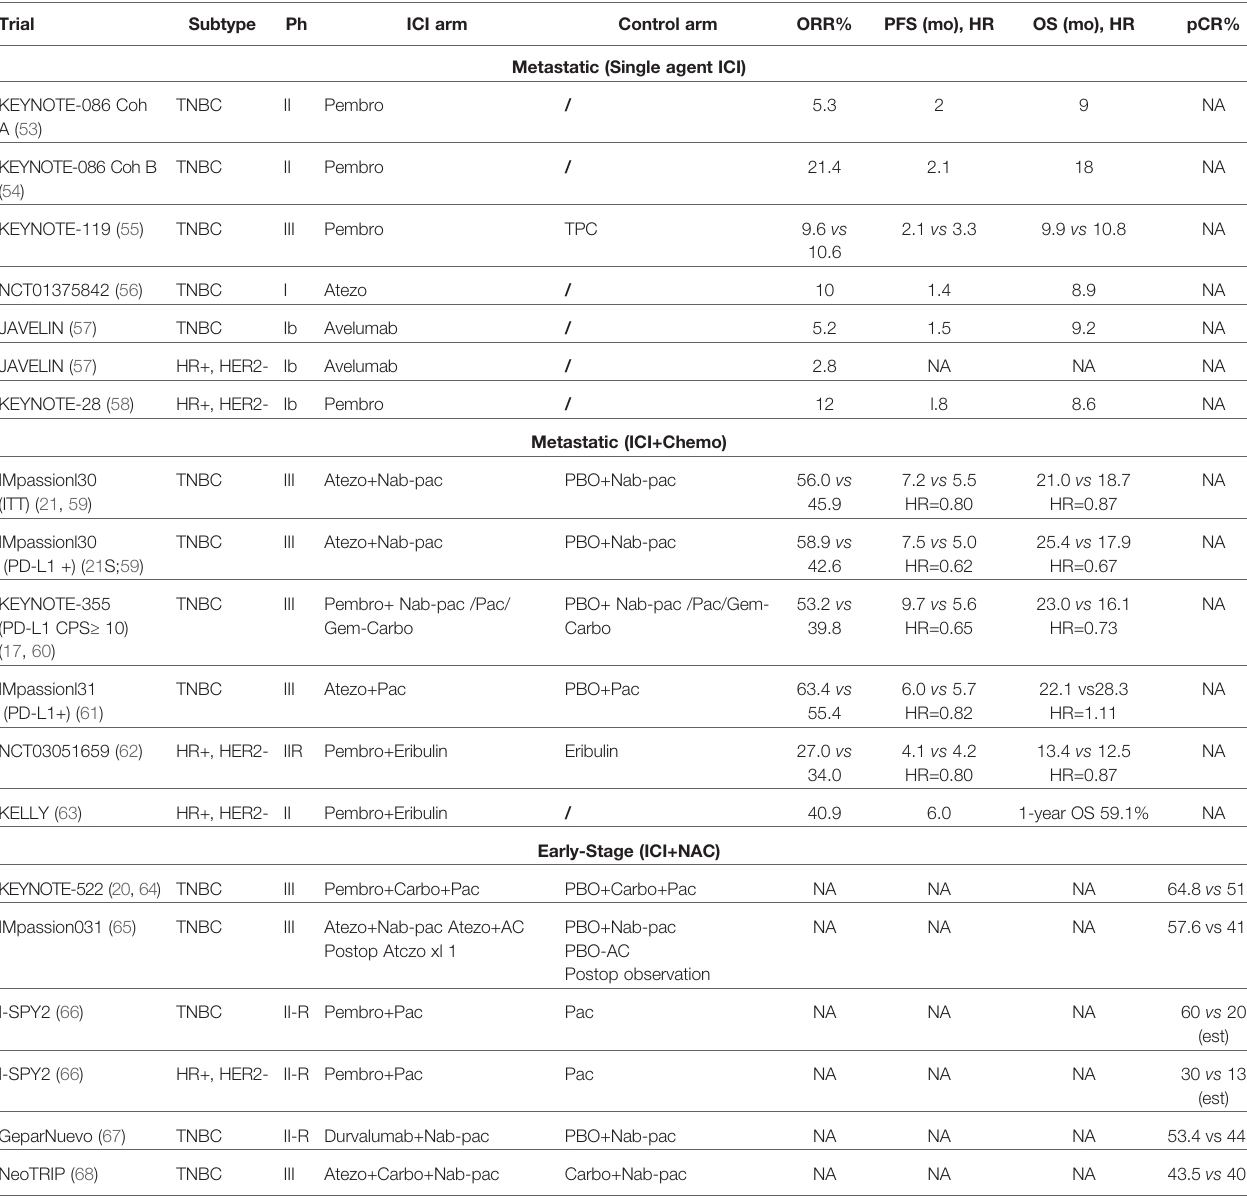
TABLE 1 | Summary of immunotherapy trials in breast